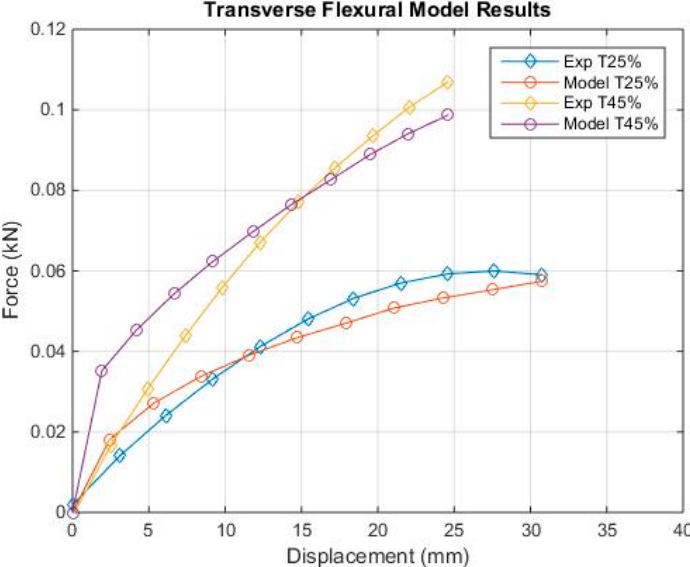
Figure 15. Three-point bending experimental and simulated stress–strain curves for the transverse direction.